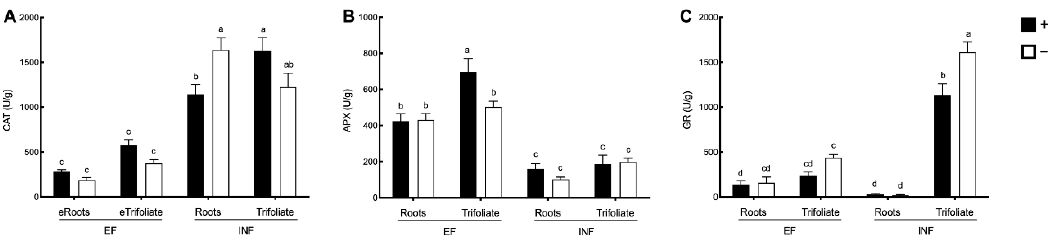
Figure 9. Enzyme activity in the roots and trifoliate leaves of efficient (EF) and inefficient (INF) soybean lines. ( A ) catalase activity (CAT); ( B ) ascorbate peroxidase activity (APX); ( C ) glutathione reductase activity (GR). Plants were grown under Fe sufficiency (+Fe, 20 µM) or Fe de fi ciency ( − Fe, no Fe) for 14 days under hydroponic conditions. Data are means ± SE; different letters indicate significant differences ( p < 0.05) by ANOVA with Tukey correction test.